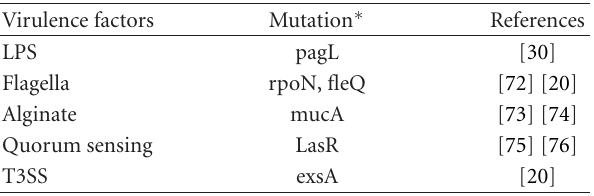
Table 2: Frequent mutations in P. aeruginosa virulence factors of CF airways